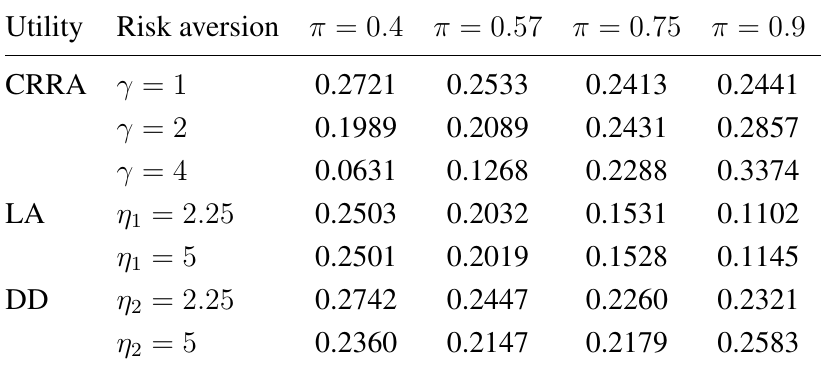
Table 4. Values of λ ∗ for a piecewise constant and U-shaped portability loss size with β = [0 . 95